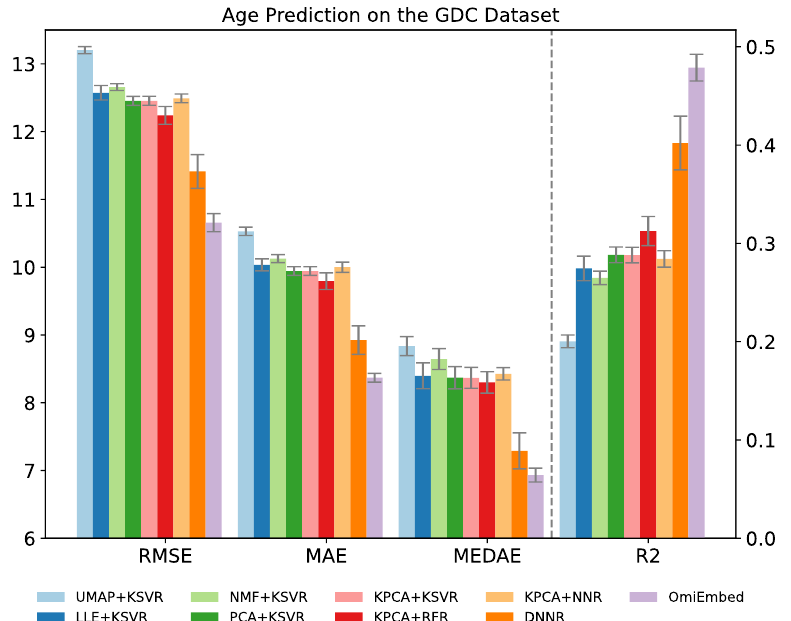
Figure 4. Performance comparison of OmiEmbed and other eight methods for the age prediction task on the GDC dataset. For root mean square error (RMSE), mean absolute error (MAE) and median absolute error (MEDAE), lower values mean better regression performance. For R 2 score, higher values mean better regression